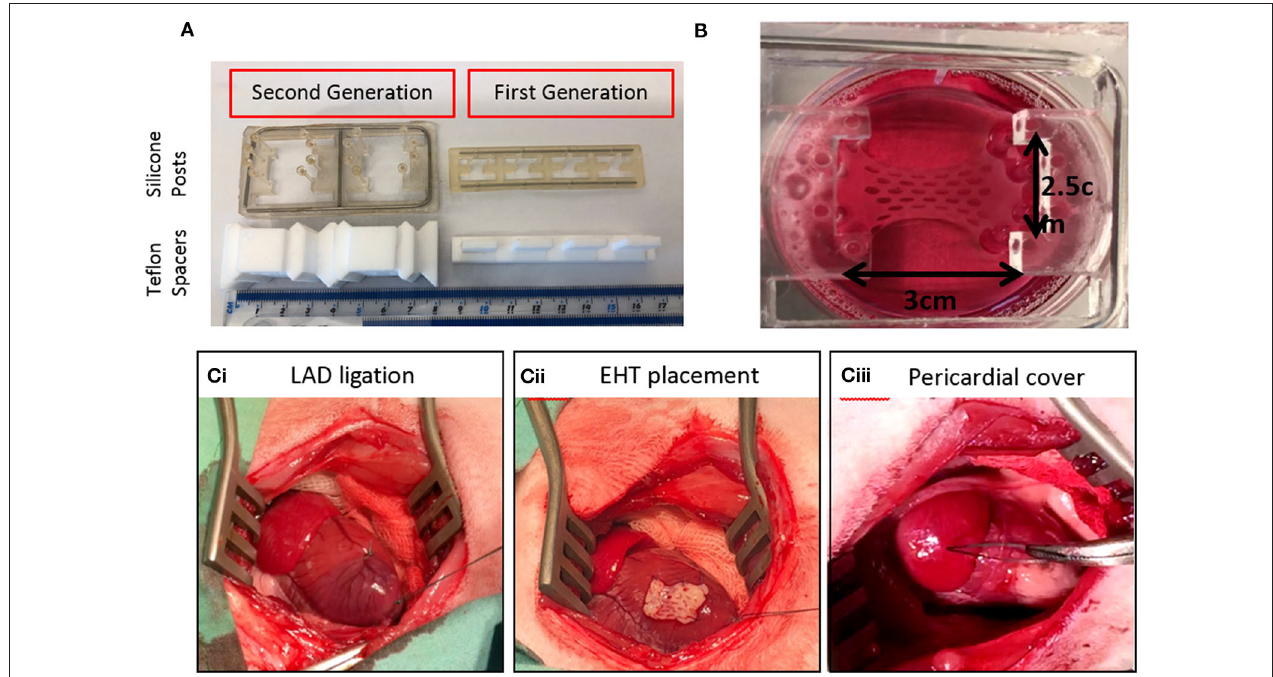
FIGURE 2 | Upscaling of EHTs to six well-format and use in a rabbit myocardial infarction model. (A) First generation and second generation EHTs with their Teflon spacers and silicone posts. (B) A live upscaled EHT in a six well-plate. (Ci) Left Anterior Descending (LAD) coronary artery ligation is shown on a rabbit heart with the ribs held open. (Cii) The EHT is attached to the heart with sutures. (Ciii) The pericardium is returned over the EHT.